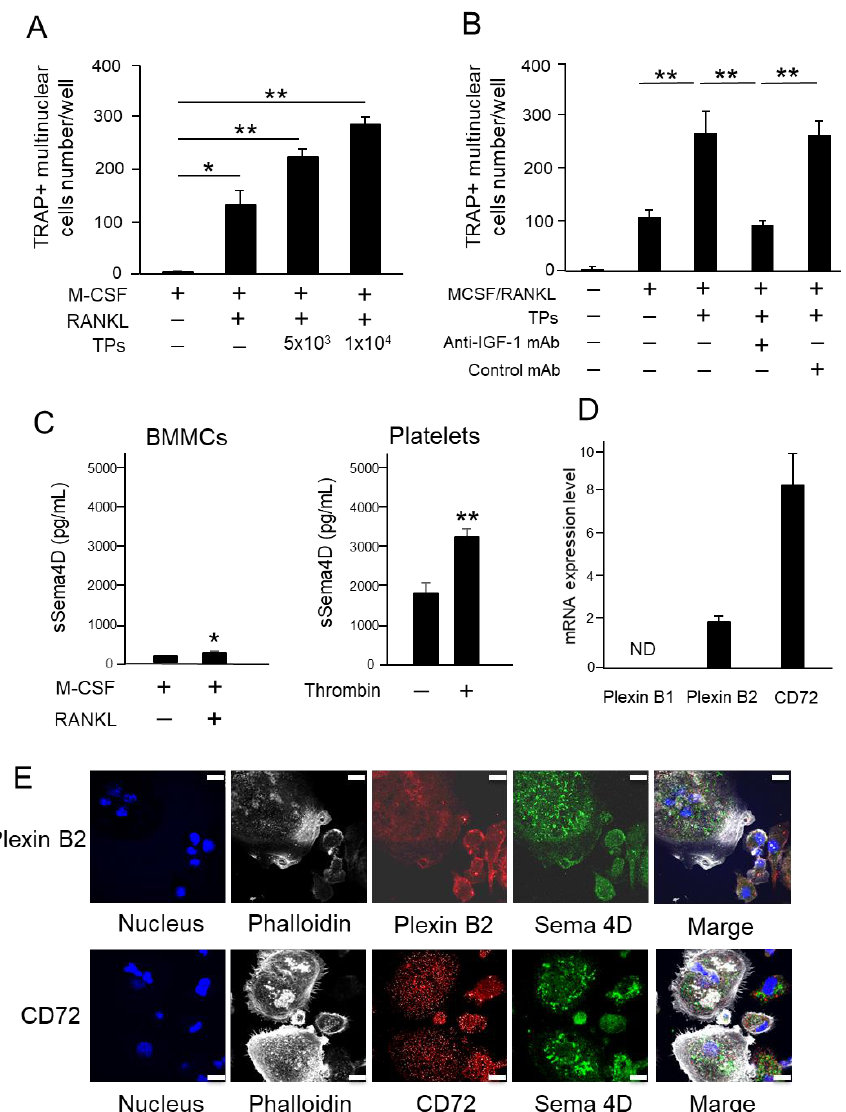
Figure 4. The effect of TPs on osteoclastogenesis and the expression of receptor of Sema4D in BMMCs. BMMCs were cultured in osteoclastogenic medium (Basal medium supplemented with M-CSF/RANKL) with or without TPs (5 × 10 3 and 1 × 10 4 cells). The number of TRAP-positive mul- tinuclear cells (over three nuclei) were counted ( A ). BMMCs were stimulated with TPs (1 × 10 4 cells) in the presence or absence of anti-IGF-1 mAb or control mAb. The number of TRAP-positive multi- nuclear cells (over three nuclei) were counted ( B ). ELISA was carried out to detect sSema4D in supernatant of M-CSF/RANKL-stimulated BMMCs or thrombin-stimulated platelets ( C ). The mRNA expression of PlexinB1, PlexinB2 and CD72 in BMMCs stimulated with MCSF/RANKL for 24 h was monitored by qPCR, whose level was then expressed in comparison to the housekeeping gene, Actb ( D ). The protein expression of PlexinB2 and CD72 was observed through immunofluorescence staining. The images in the first row are indicated as “PlexinB2” while those in the bottom row are indicated as “CD72”. Blue (DAPI): Nuclei, White (Alexa 647): Phalloidin, Red (PE): Plexin B2 or CD72, and Green (FITC): Sema4D. Bar = 10 µm. ( E ). Data represent the mean ± SD of three inde- pendent experiments. Values are mean ± S.D. * p < 0.05, ** p < 0.01. ND: No statistically significant difference. +: Applied. − : Not applied.